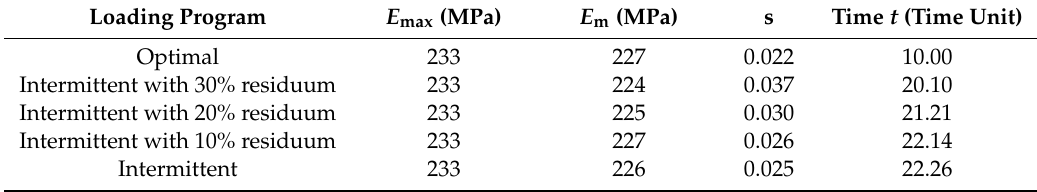
Table 3. Parameters for the analyzed loading programs for the given maximal value E